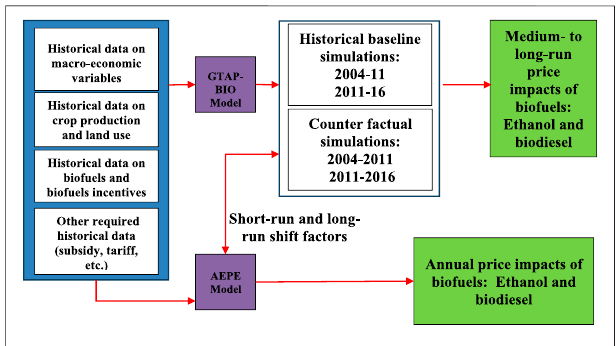
FIGURE 1 | The overall modeling